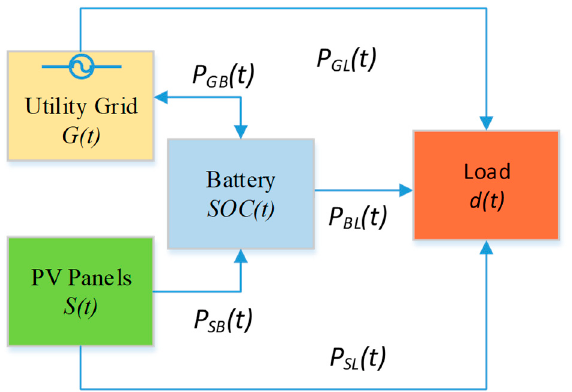
Figure 5. A block diagram for showing different actors involved in optimized grid utilization in an intermittent grid environment.